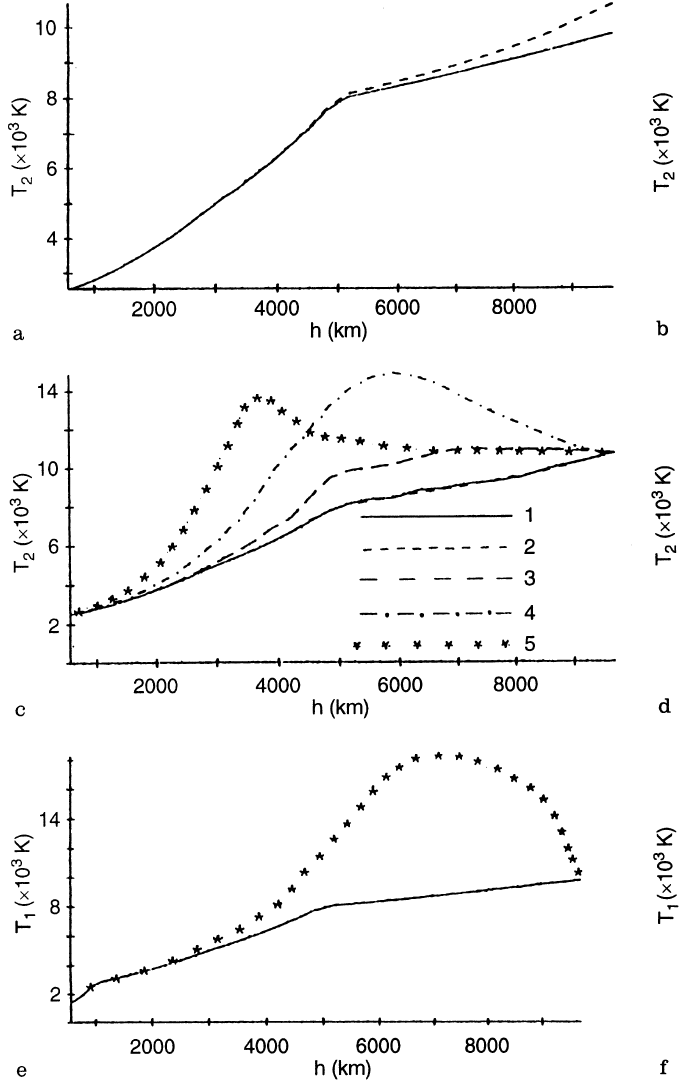
Fig. 2a–f. Temperatures T j of protons (cid:133) j (cid:136) 1 (cid:134) and electrons (cid:133) j (cid:136) 2 (cid:134) versus altitude h calculated for the turbulent plasma located in the magnetic flux tube given in the nightside auroral magnetosphere. The maximum value of the ratio of turbulent wave energy to thermal electron energy W = (cid:133) n 2 k B T 2 (cid:134) at h (cid:136) h m equals a, b 10 (cid:255) 2 , d, f 10 (cid:255) 3 , c, e 10 (cid:255) 4 . Besides, in a, b , it is C (cid:136) 1 : 5 (cid:1) 10 2 s (cid:255) 1 , and the density of the